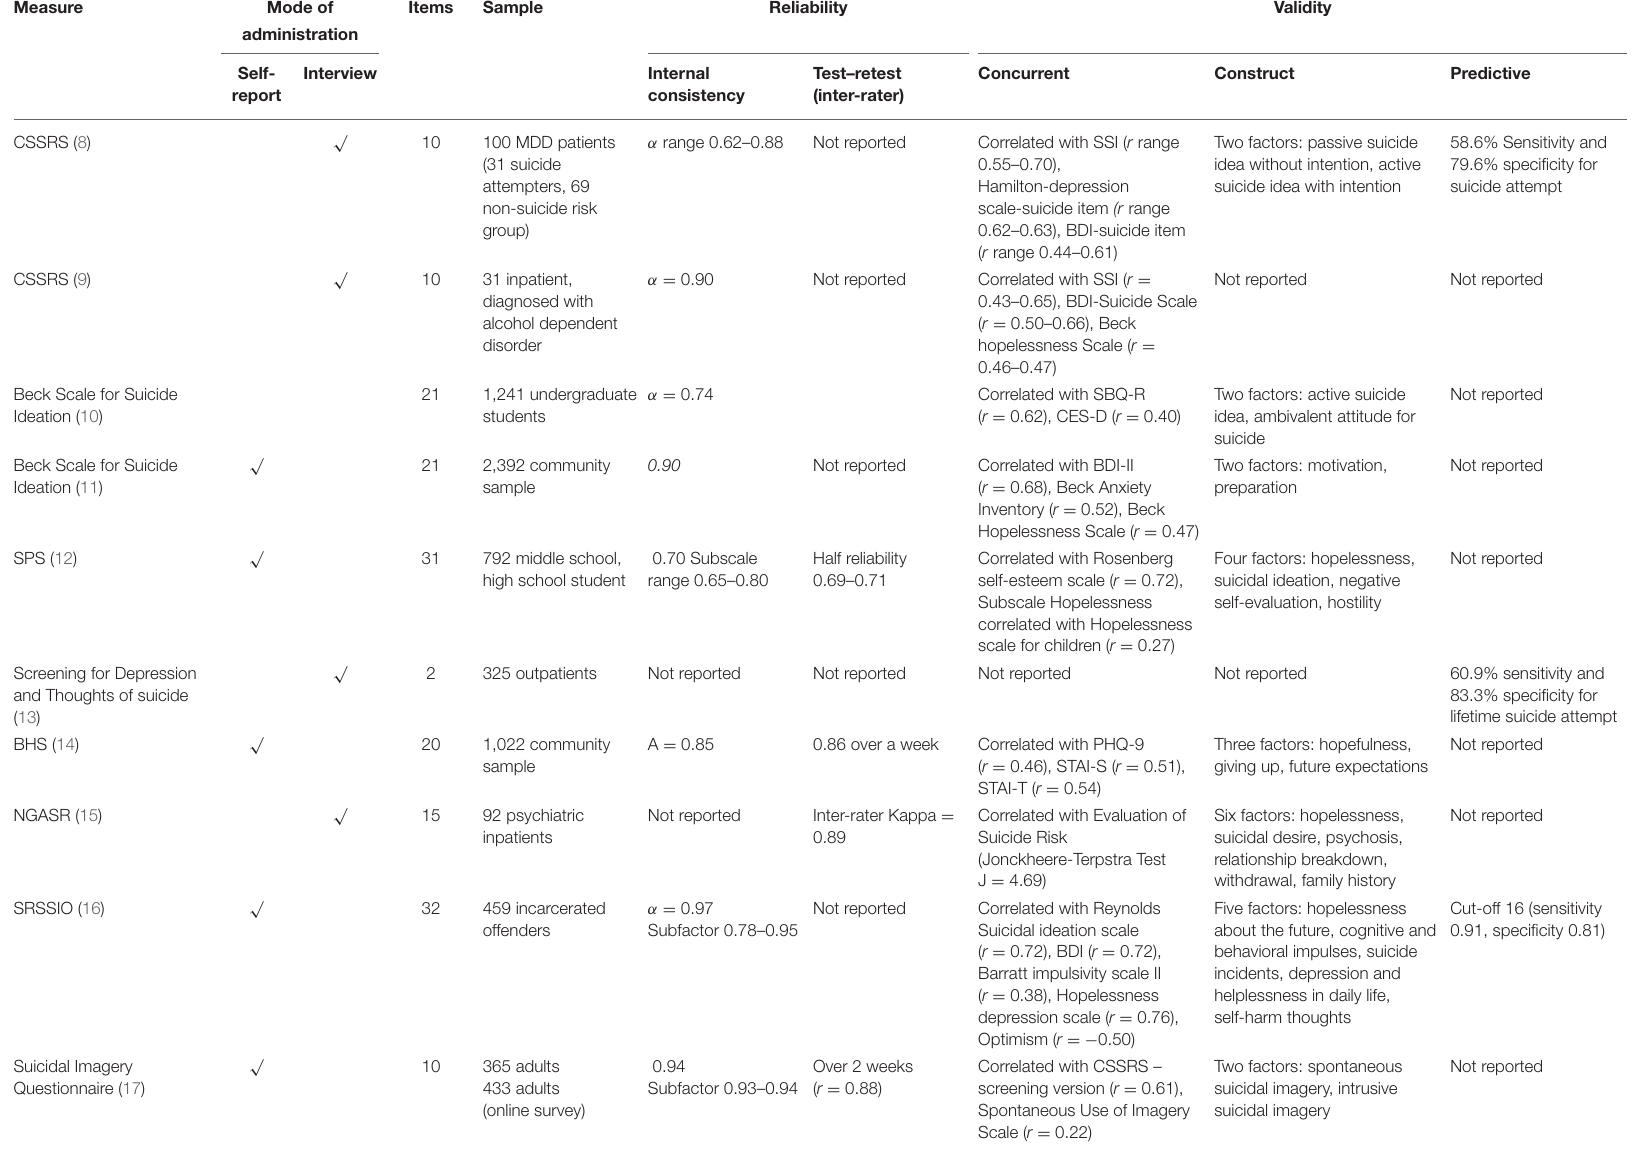
TABLE 1 | Characteristics and psychometric properties of suicide